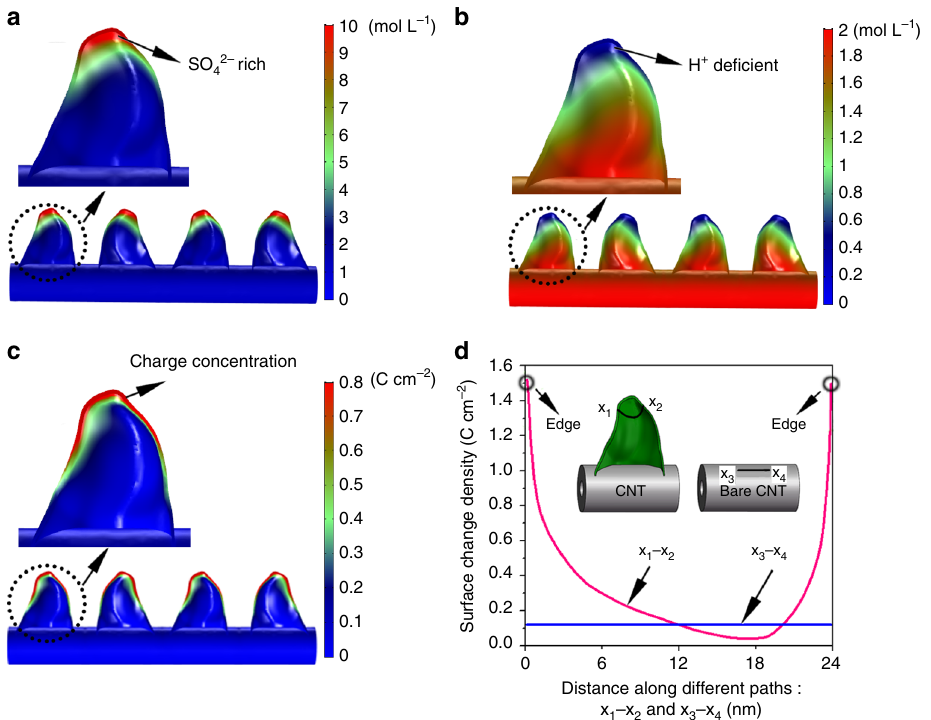
Fig. 5 Simulations of CNT/GP micro-conduit electrodes in 1 M H 2 SO 4 at a voltage of 1 V. a Contour plot of counter-ion (SO 4 2 – ) distribution (initial density: 1 M). b Contour plot of co-ion (H + ) distribution (initial density: 2 M). c Contour plot of surface charge density distribution . d Comparisonof surface charge density between CNT/GP and bare CNT cases. The magenta line corresponds to the path x 1 – x 2 passing through both edge and basal regions of a typical petal in the CNT/GP case, and blue line corresponds to the path x 3 – x 4 on the top outer surface of a bare CNT along its axial